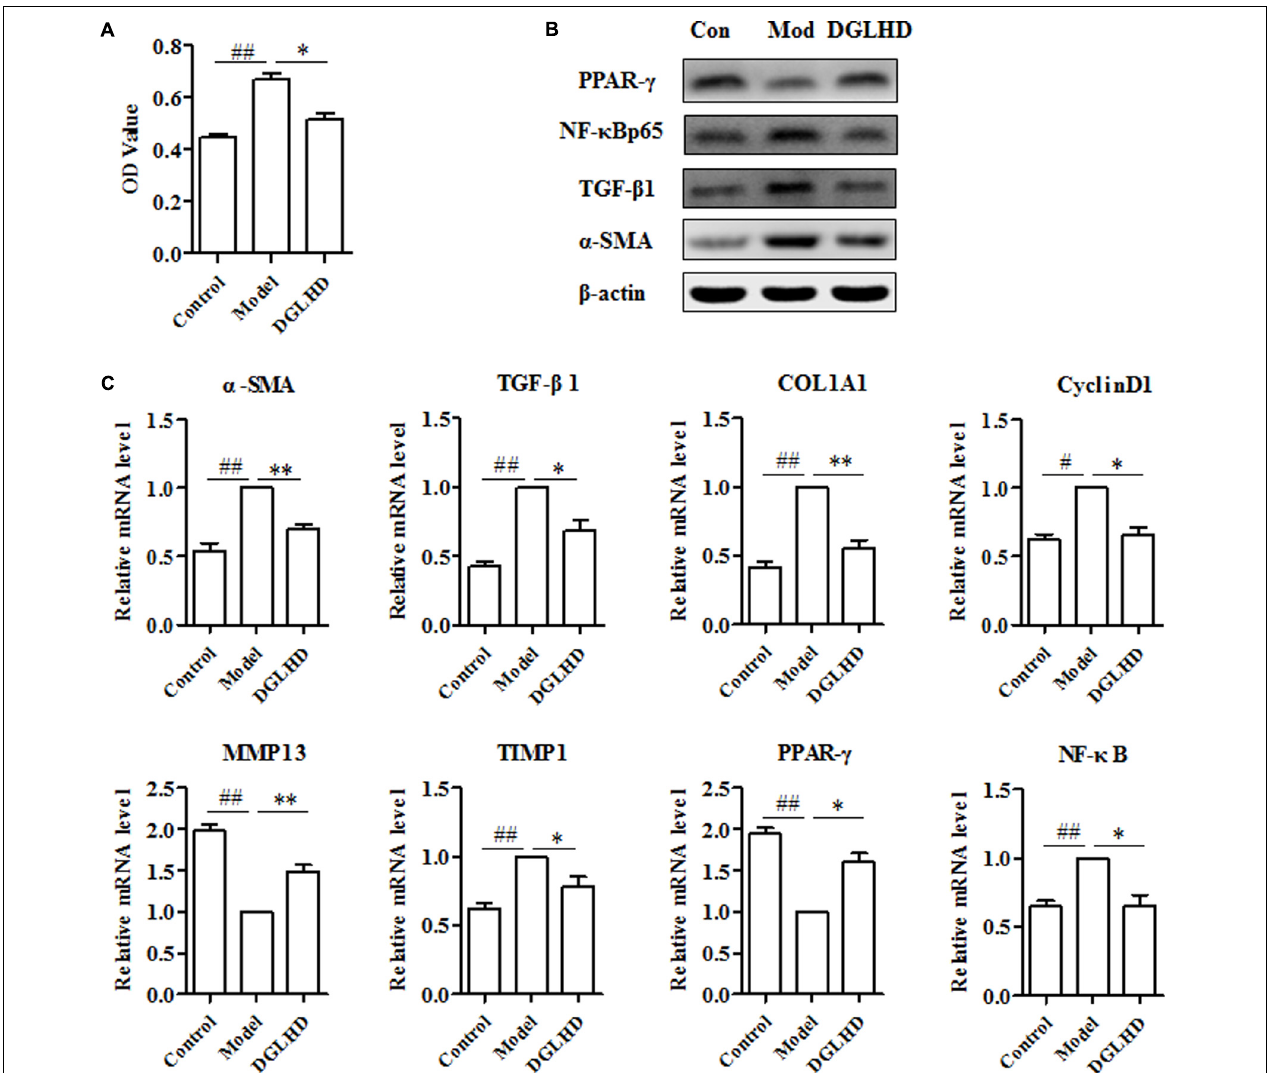
FIGURE 7 | Dangguiliuhuang decoction exerted anti-fibrotic effects on HSC-T6 cells. HSC-T6 cells were activated by TGF- β 1 (5 ng/mL) for 24 h to induce fibrosis. (A) Proliferation of HSC-T6 cells. (B) Western blot analysis of α -SMA, TGF- β 1, PPAR- γ , and NF- κ B protein expressions. (C) Expression level of fibrosis-related genes. Data shown as mean ± SEM ( n = 4). # P < 0.05, ## P < 0.01 compared to Control. ∗ P < 0.05, ∗∗ P < 0.01 compared to